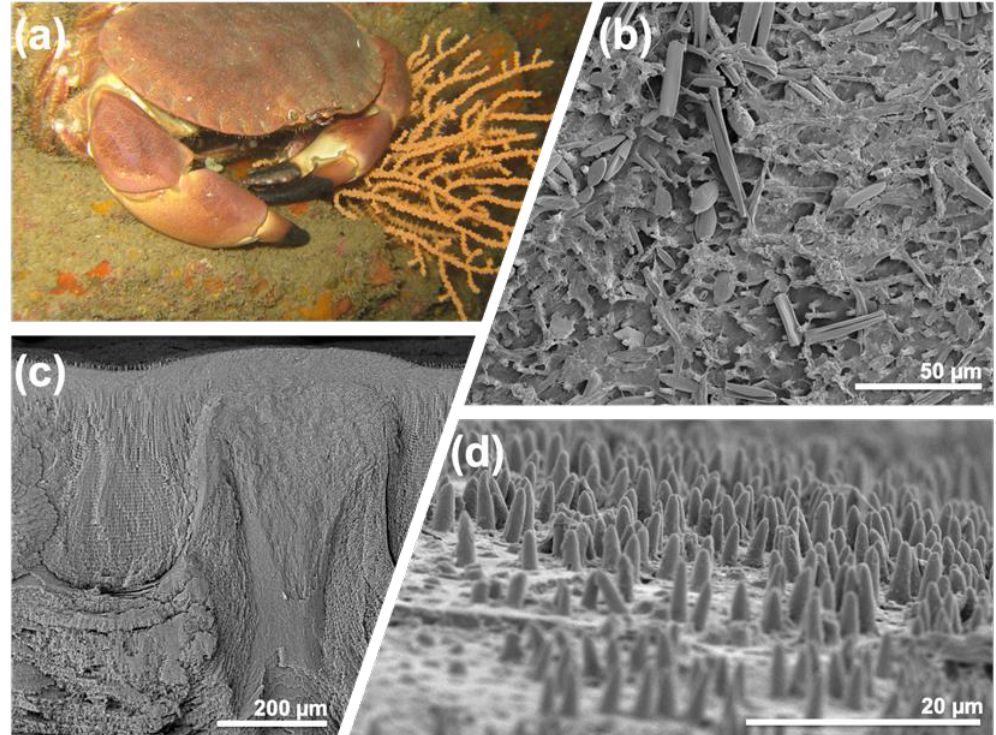
Figure 4. Crustaceans continue to be a source of inspiration in the search for new antifouling strategies and other technologies such as nanostructured composites. Here, electron microscopy images of the surface of the carapace of the marine decapod crustacean Cancer pagurus ( a ), also showing laminar structure in cross-section ( c , scale bar = 200 µm) show the presence of micro-topographic features presented to any colonising organisms (epibionts). Many of the upper and under surfaces of C. pagurus are covered in these micro-scale spines (microtrichia), approximately some 5 to 20 microns in length ( d , scale bar = 20 µm). These surfaces do sustain some colonisation (in this case, benthic diatoms species) ( b , scale bar = 50 µm); however, the role and extent of any natural antifouling provided by these surface structures against larger epibionts (particularly other calcareous colonising species such as polychaetes) are not yet fully understood. Image ( a ) by Matthieu Sontag from Wikimedia Commons, licensed under CC BY-SA 4.0.